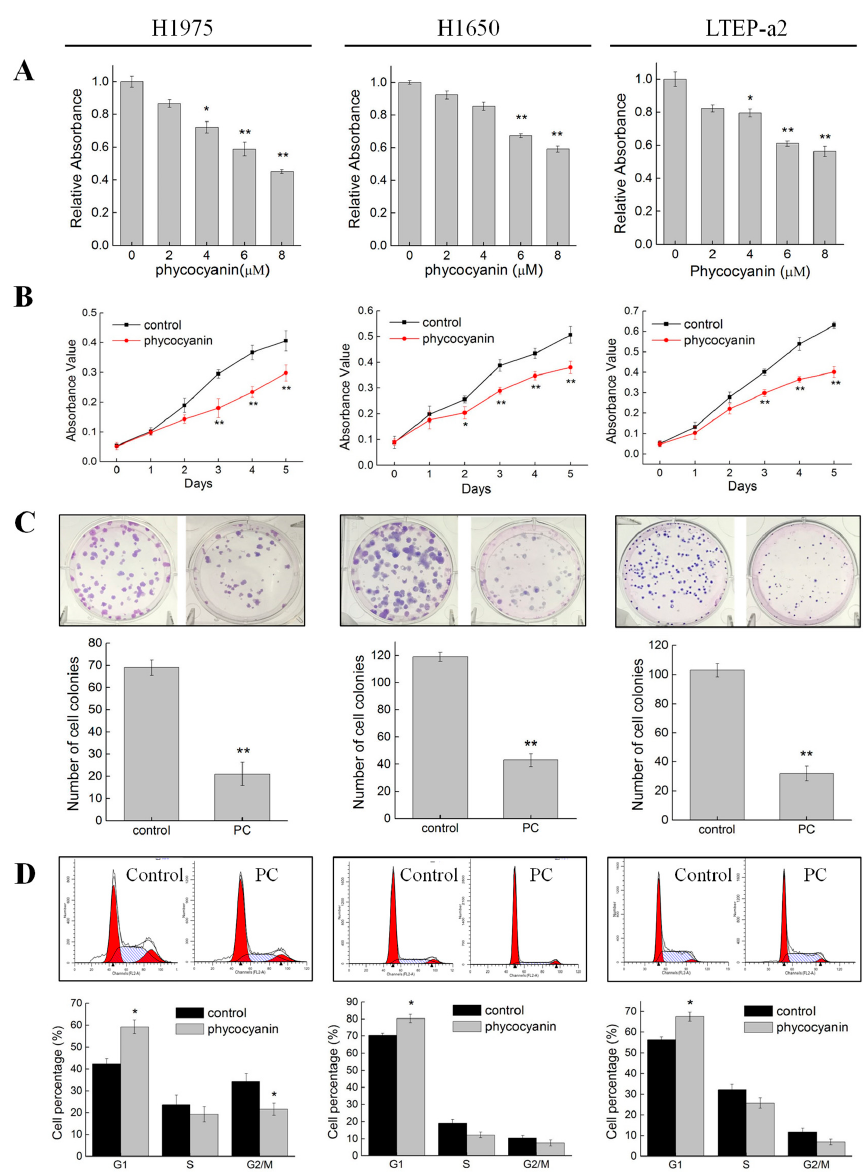
Figure 1. Phycocyanin suppressed the growth and viability of non-small cell lung cancer cells. ( A ) Survival rate assay of H1975, H1650, and LTEP-a2 cells after different concentrations of phycocyanin (0, 2, 4, 6, and 8 µM) treatment for 24 h. ( B ) Cell proliferation assay of H1975, H1650, and LTEP-a2 cells after 6 µM phycocyanin treatment for 24 h. The proliferation experiment lasted for five days. ( C ) Cell colony formation assay of H1975, H1650, and LTEP-a2 cells after 6 µM phycocyanin treatment for 24 h, followed by continuous incubation in fresh media. The cell colony formation experiment lasted for 12–15 days. ( D ) Cell cycle analysis of H1975, H1650, and LTEP-a2 cells after 6 µM phycocyanin treatment for 48 h. PC, phycocyanin treated group; control, non-phycocyanin treated group. Bars represent mean ± SD. *, p < 0.05; **, p < 0.01.